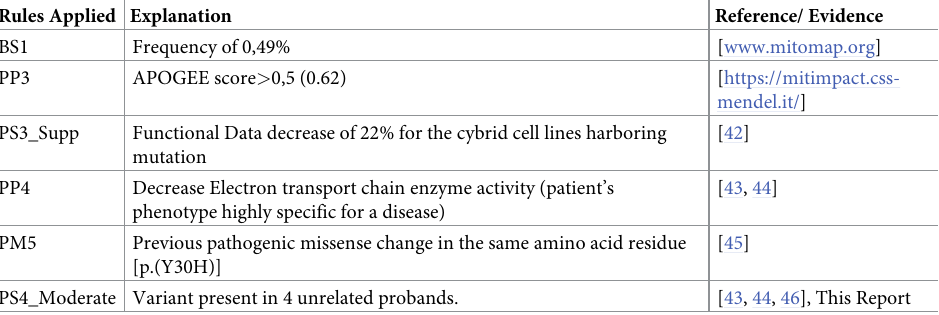
Table 3. Summary of rules applied for m.3395A > G p.(Tyr30Cys) variant curation in MT-ND 1.